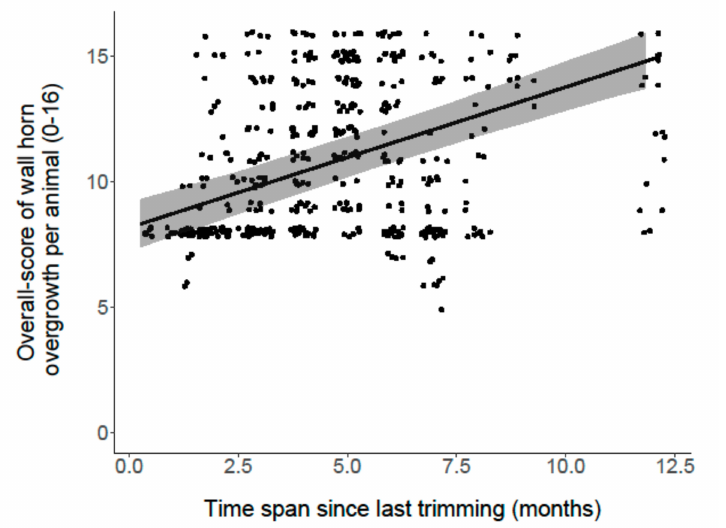
Figure 4. Association of “time span since last trimming” (in months) and “wall horn overgrowth per animal”. Dots show jittered raw data. The black line represents the model estimate, the gray colored area the 95% confidence